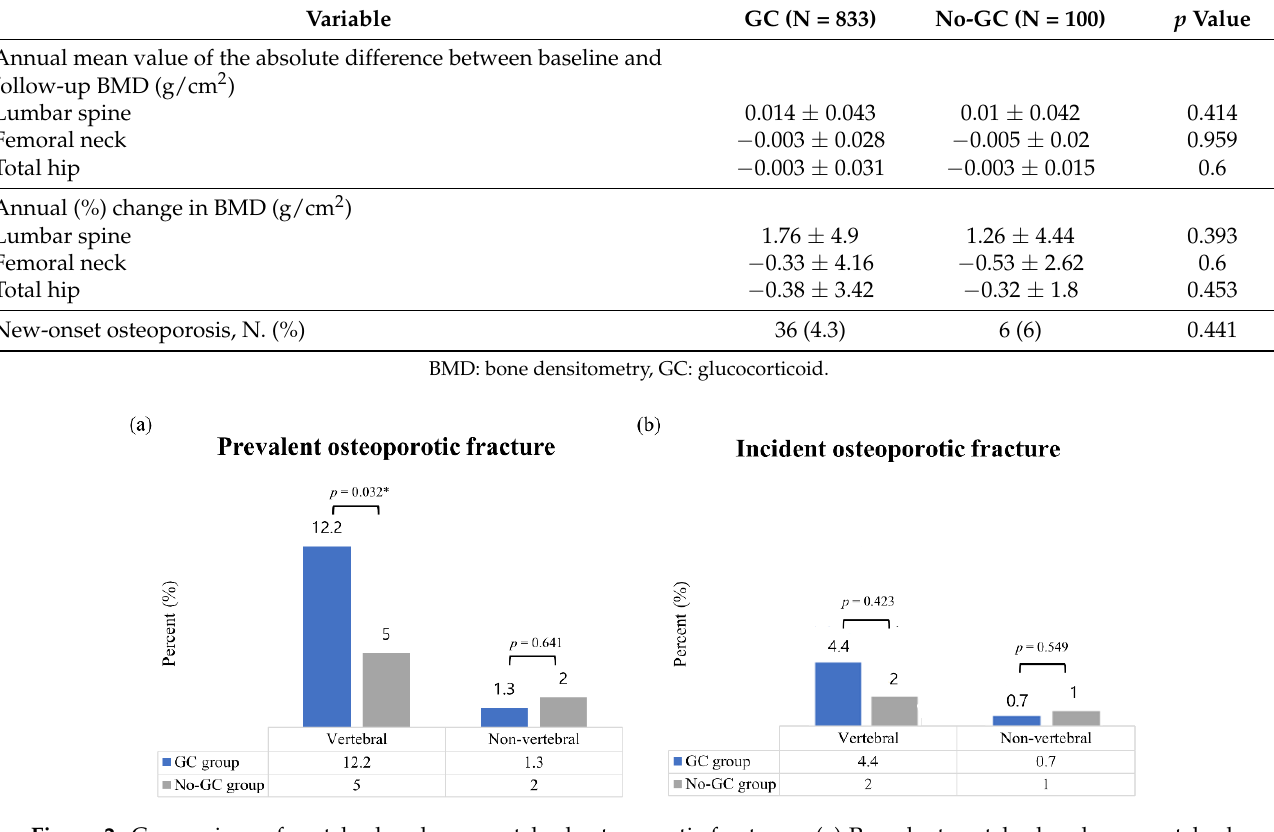
Figure 2. Comparison of vertebral and non-vertebral osteoporotic fractures. ( a ) Prevalent vertebral and non-vertebral fractures at baseline; ( b ) Incidental vertebral and non-vertebral fractures after baseline. GC: Glucocorticoid. * p < 0.05.